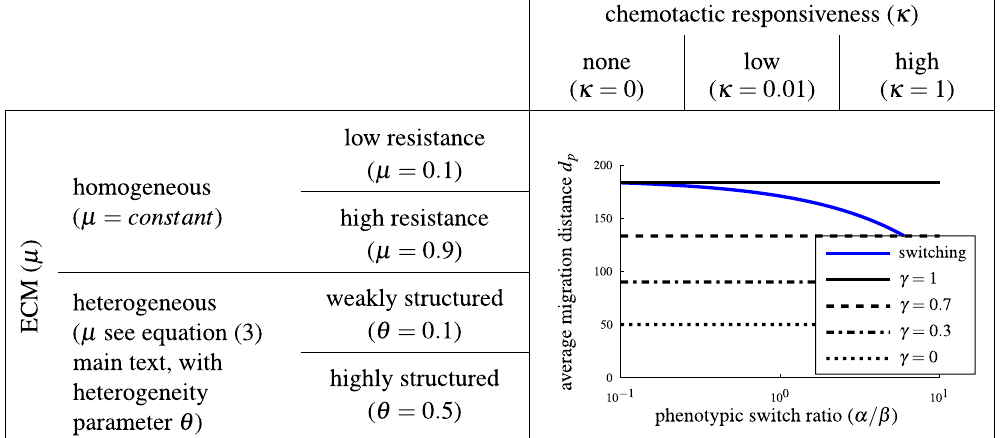
Table 1. Overview of simulation scenarios. We study different environmental conditions: homogeneous or heterogeneous ECM structure (left column) in combination with different chemotactic responsiveness (top row). In each scenario, we measure the average migration distance dp of switching and non-switching populations depending on the switch ratio α / β . As illustrated in the figure, the switching population results (blue line) are compared to those of non-switching populations with different M -cell fractions: γ = 1 (pure M - cell population; solid line), γ = 0.7 (70% M -cells, 30% A -cells; dashed line), γ = 0.3 (30% M -cells, 70% A -cells; dash-dot line) and γ = 0 (pure A -cell population; dotted